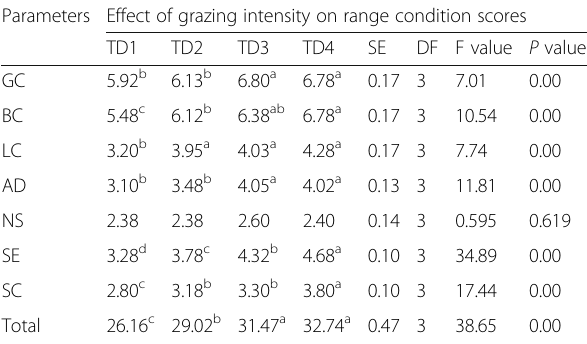
Table 2 Effects of grazing intensity on range condition scores from water source point in Chagni ranch, Northwest Ethiopia Parameters Effect of grazing intensity on range condition